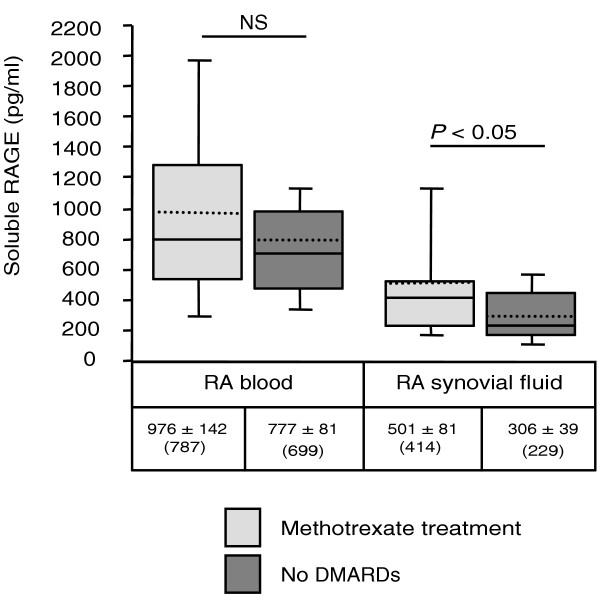
Levels of soluble receptor for advanced glycation end products (soluble RAGE) in blood and synovial fluids of rheumatoid arthritis (RA) patients who received methotrexate treatment or were not treated with disease-modifying antirheumatic drugs (DMARDs) at all. Box plots show the 25th and 75th percentiles. Horizontal lines in bold within boxes indicate medians, and dashed lines indicate means. Vertical bars indicate the 5th and 95th percentiles. Statistical differences with respect to soluble RAGE levels between groups were calculated using the Mann–Whitney U test. Mean ± standard error of the mean (median) values are shown. NS, not significant.